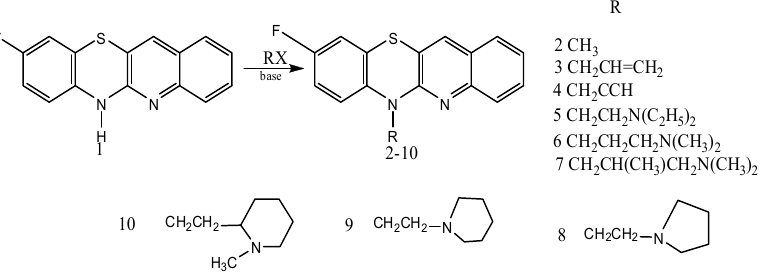
Figure 4. Synthesis of tetracyclic azaphenothiazine derivatives.